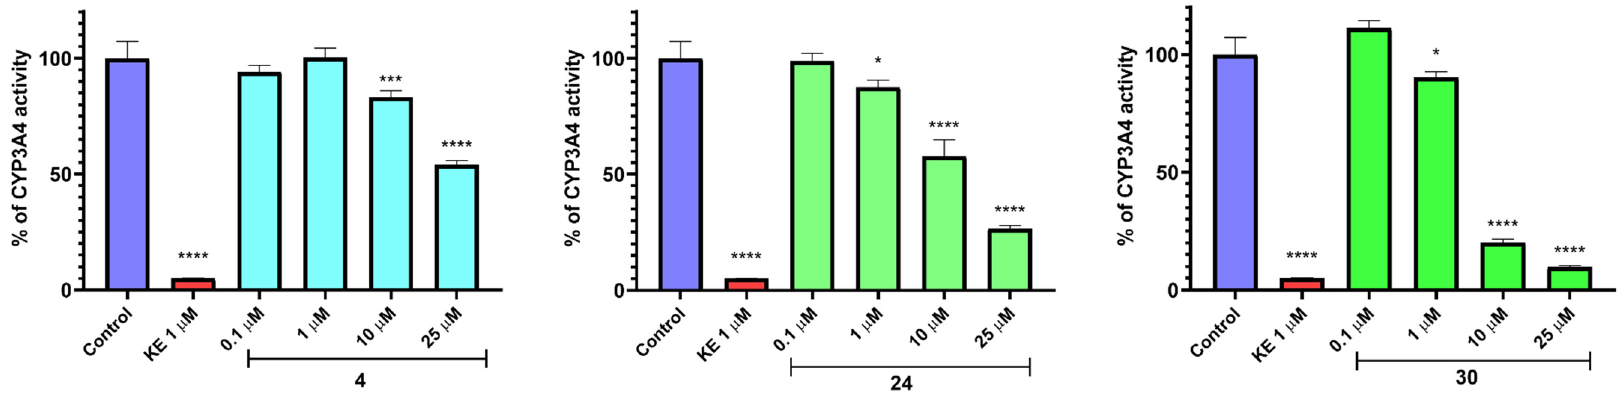
Figure 5. The influence of 4 , 24 , 30 , and reference inhibitor ketoconazole (KE) on CYP3A4 activity. Statistical significance (* p < 0.05, *** p < 0.001, **** p < 0.0001) was analyzed by Graph Pad Prism 8.0.1 software using one-way ANOVA and Bonferroni’s multiple comparison post test. The compounds were examined in triplicate.